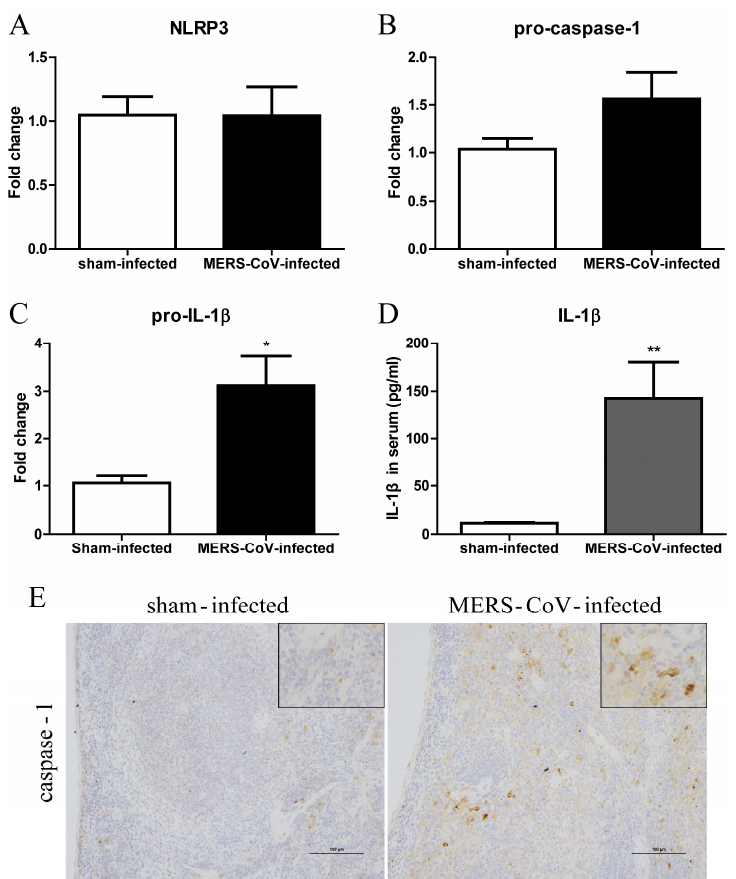
Figure 2. MERS-CoV infection induces pyroptosis in hDPP4-transgenic mice. ( A – C ) Transcription of NLRP3, pro-caspase-1, and pro-IL-1β in lung tissue at Day 3 post-MERS-CoV infection ( n = 5–6 per group). ( D ) Concentration of IL-1β in serum at Day 3 post-MERS-CoV infection. Data are expressed as means ± SEM ( n = 5–6 per group). * p < 0.05, ** p < 0.01 (Student’s t test with Welch’s correction). ( E ) Representative images of immunohistochemical staining of caspase-1 in lung tissue on Day 7 post- challenge of sham-infected and MERS-CoV-infected mice (scale bars = 100 μm).